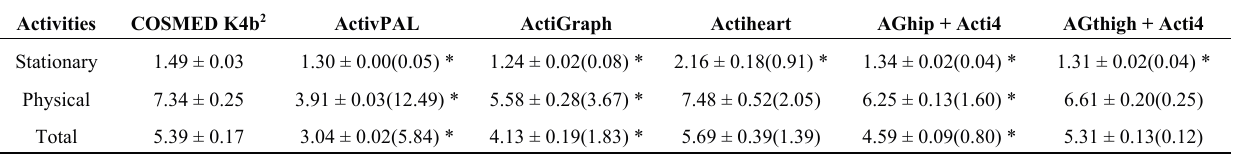
Table 4. Comparisons of EE of stationary and physical activities measured by COSMED K4b 2 (indirect calorimetry) and estimated by different methods during a semi-standardized